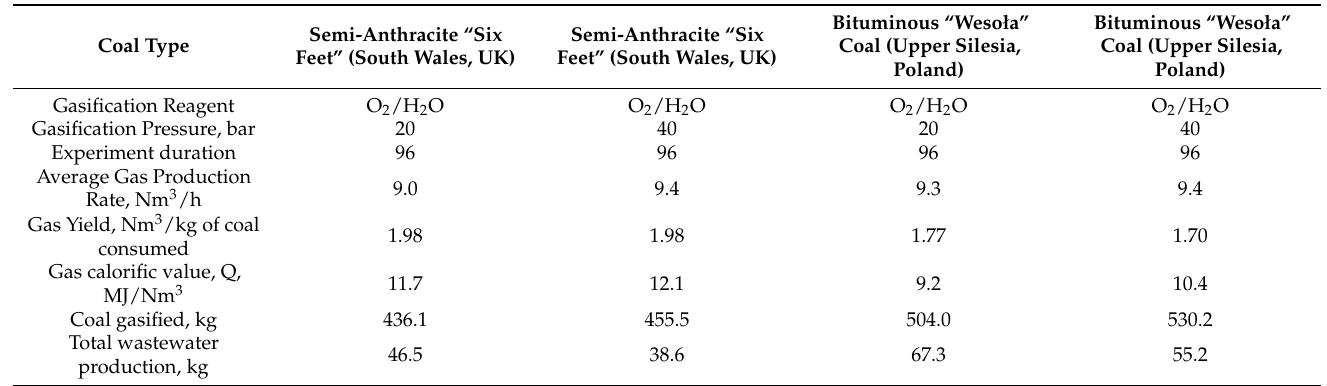
Table 3. General summary of UCG experiments